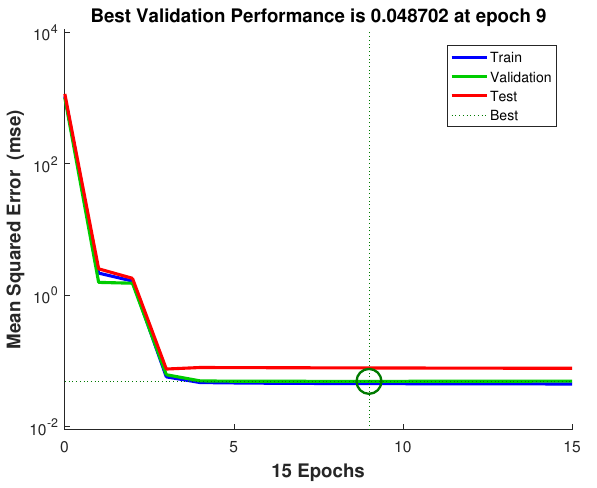
Figure 7. Training process-first test